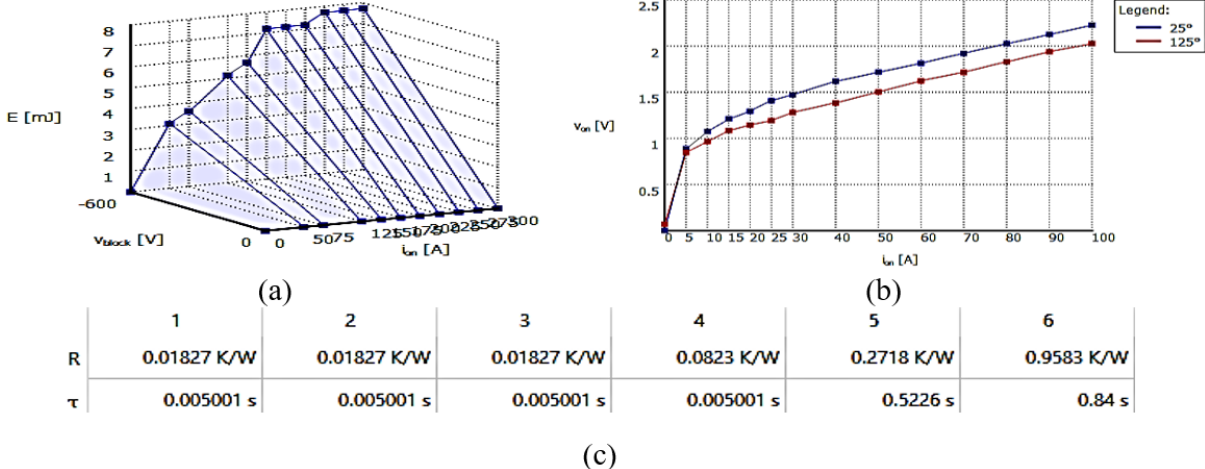
Fig. 8. Silicon made SEMIKRON Freewheeling diode S 7 -S 8 (a) Reverse recovery loss (b) Output characteristics-Conduction loss (c) Thermal impedance